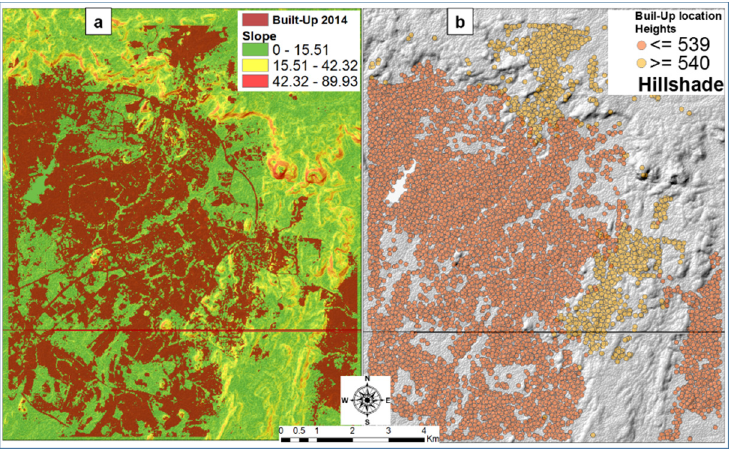
Figure 5. Assessment of the influence of topography on urban expansion. ( a ) Shows the GIS overlay of built-up on DEM derived slope. While ( b ) presents a constraint analysis showing built-up dependency on suitable heights as overlaid onto hillshade.